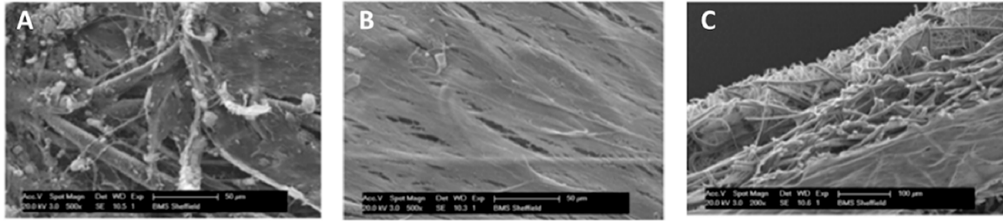
Figure 3. SEM face ( A , B —scale bar = 50 µm) and side ( C —scale bar = 100 µm) views of the tri-layer scaffold following co-culture with hBMSCs and fibroblasts. Matrix mineralization is observed on